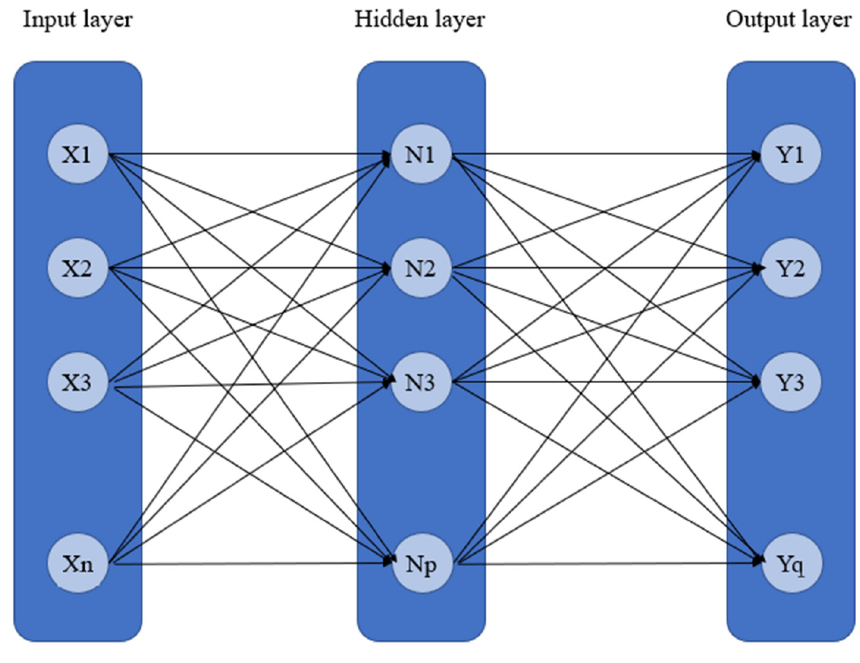
Figure 2. ANN structure.